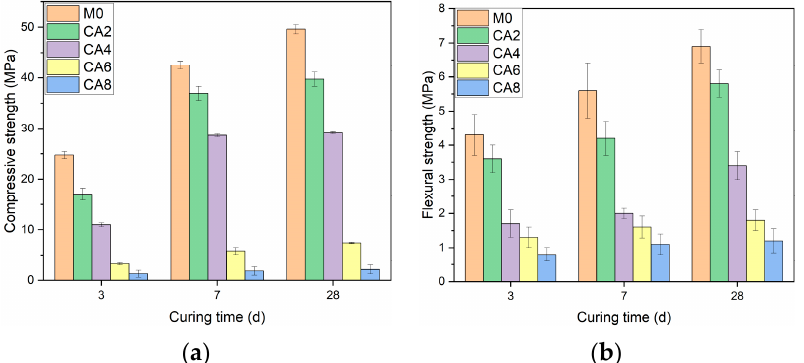
Figure 7. E ff ect of citric acid on compressive and fl exural strength of AAS with di ff erent dosages. ( a ) Figure 7. Effect of citric acid on compressive and flexural strength of AAS with different dosages. Uncon fi ned compressive strength; ( b ) fl exural strength. ( a ) Unconfined compressive strength; ( b ) flexural